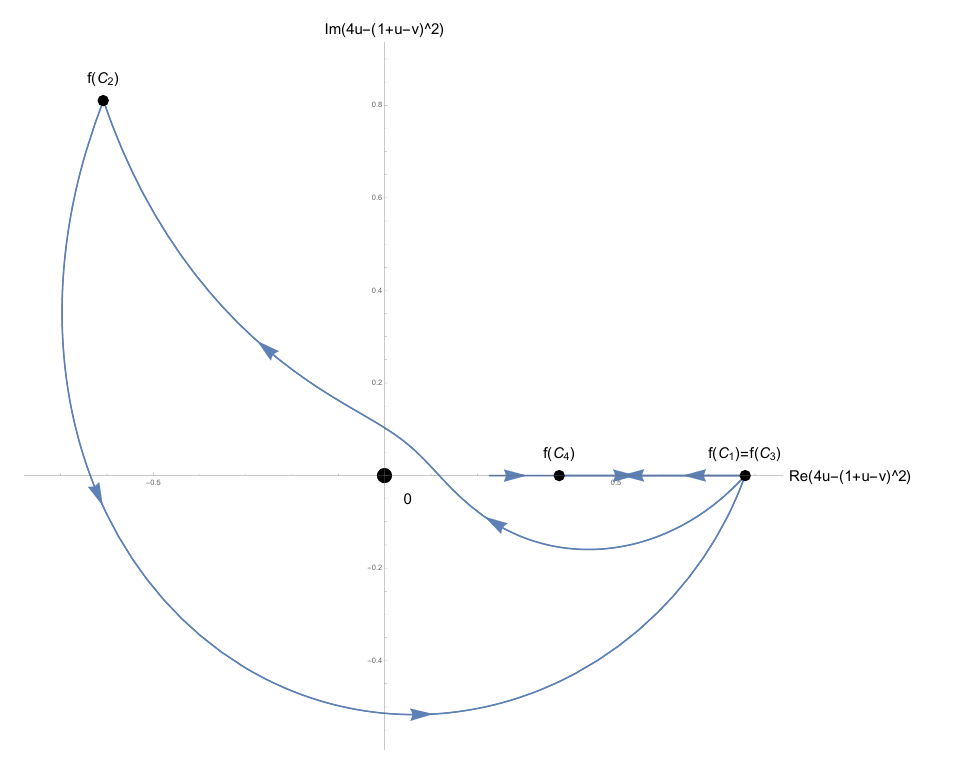
) to denote the i i